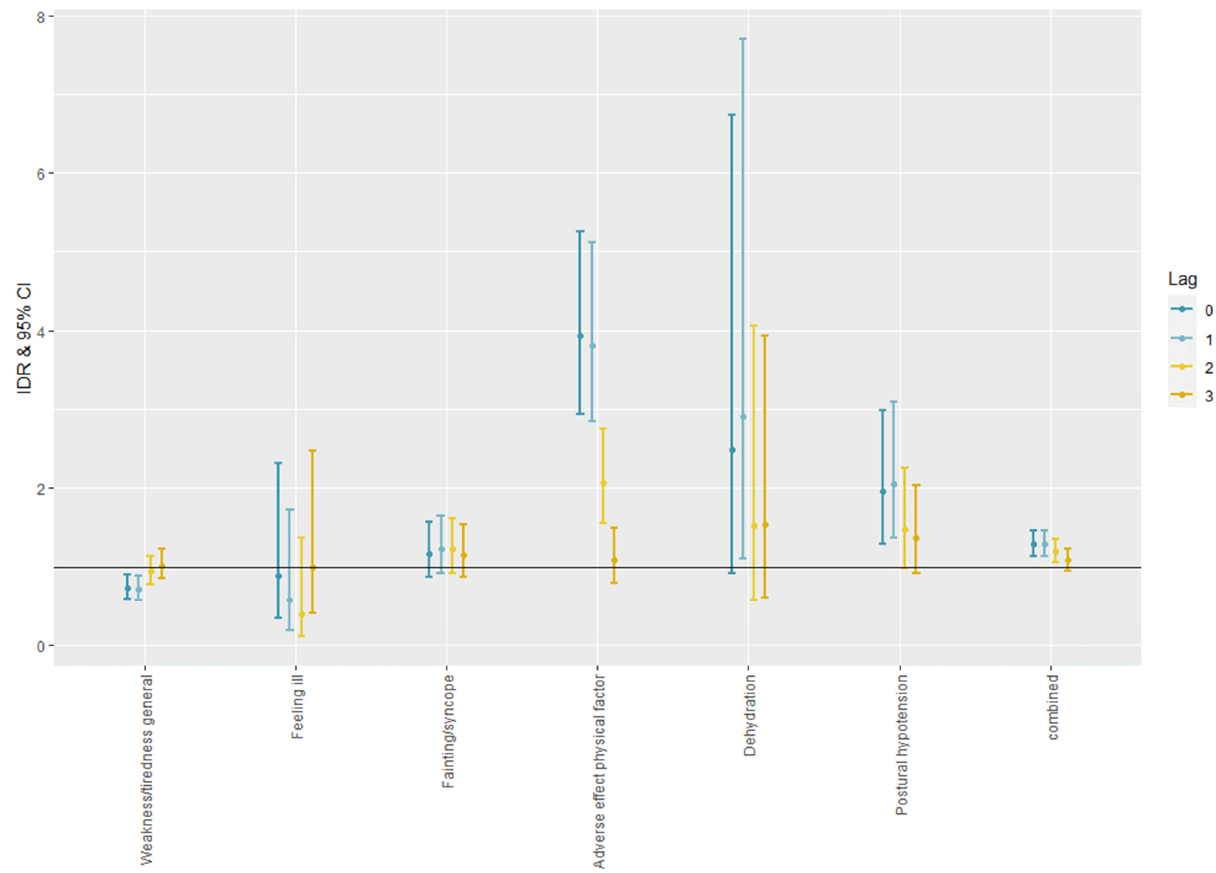
Figure 2. The IDRs with 95% CI for general and heat-related morbidities.